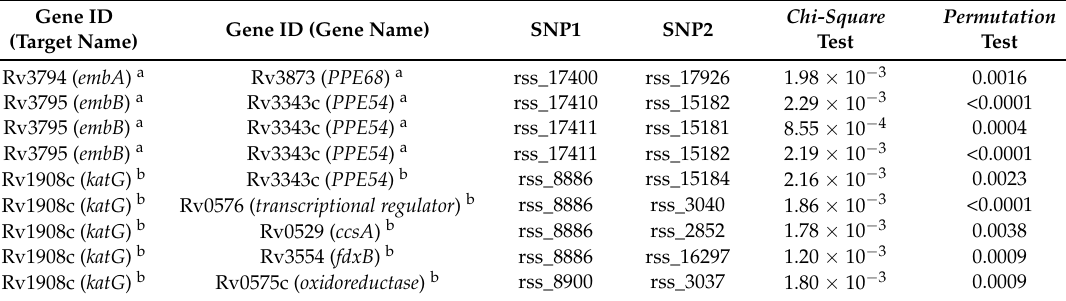
Table 4. The obtained gene pairs containing target genes in dataset